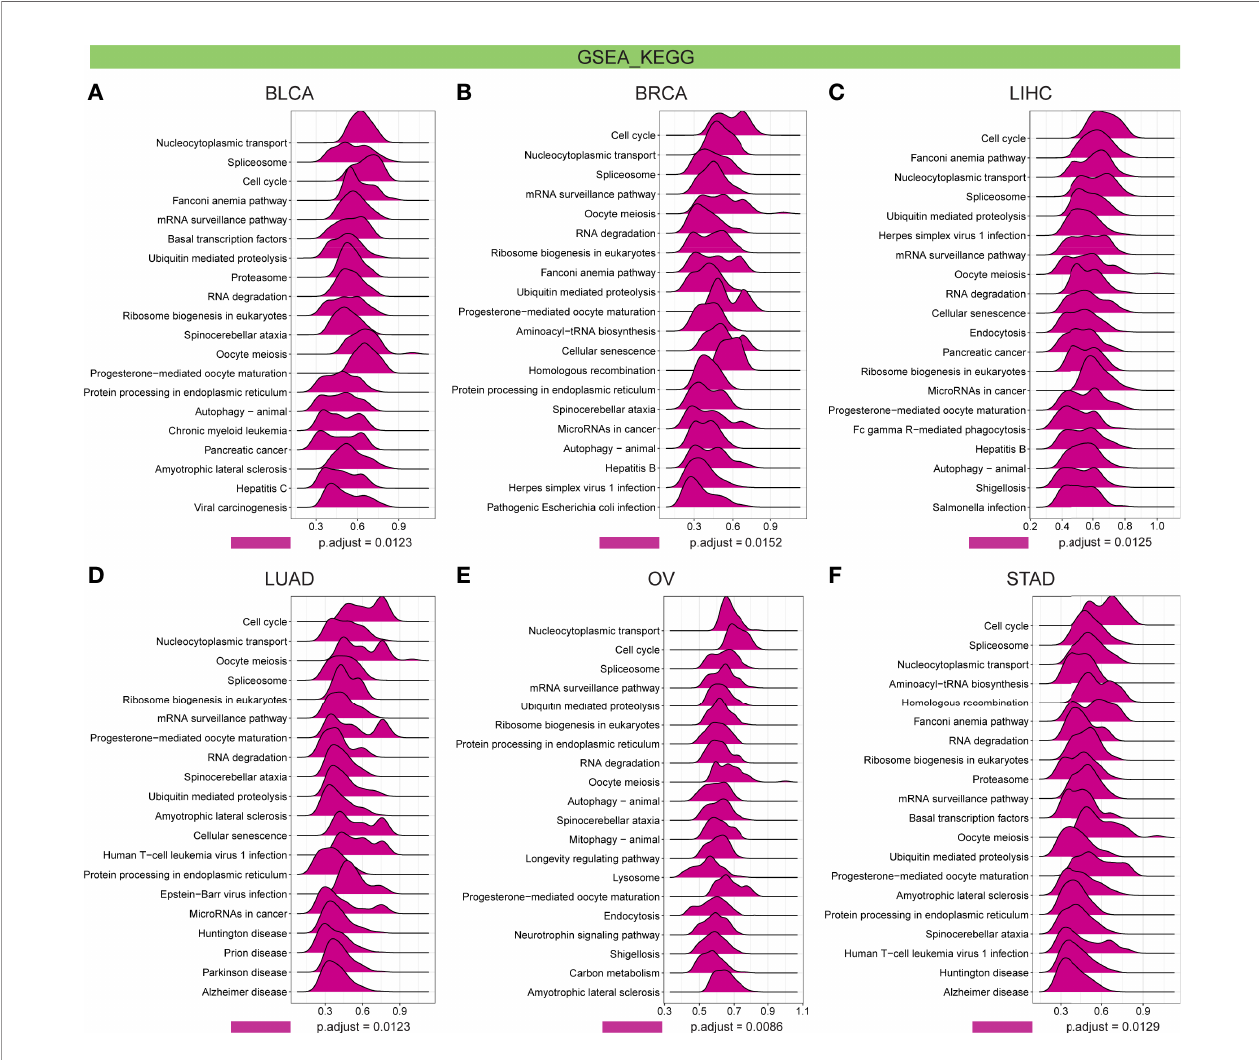
FIGURE 10 | KEGG annotations of FBXO5 in the indicated six types of tumors using GSEA, including (A) BLCA, (B) BRCA, (C) LIHC, (D) LUAD, (E) OV, and (F)